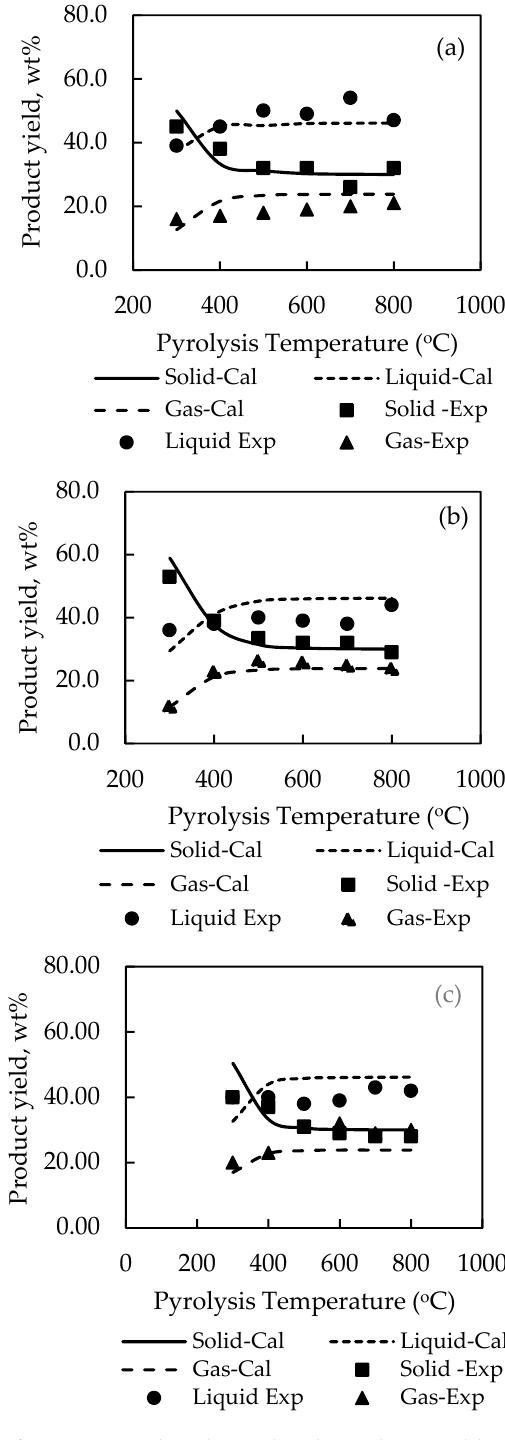
Figure 7. Comparison of experimental and simulated pyrolysis yields for ( a ) palm kernel cake, ( b ) longan fruit seed and ( c ) cassava pulp residue by using pyrolysis reaction model G02.